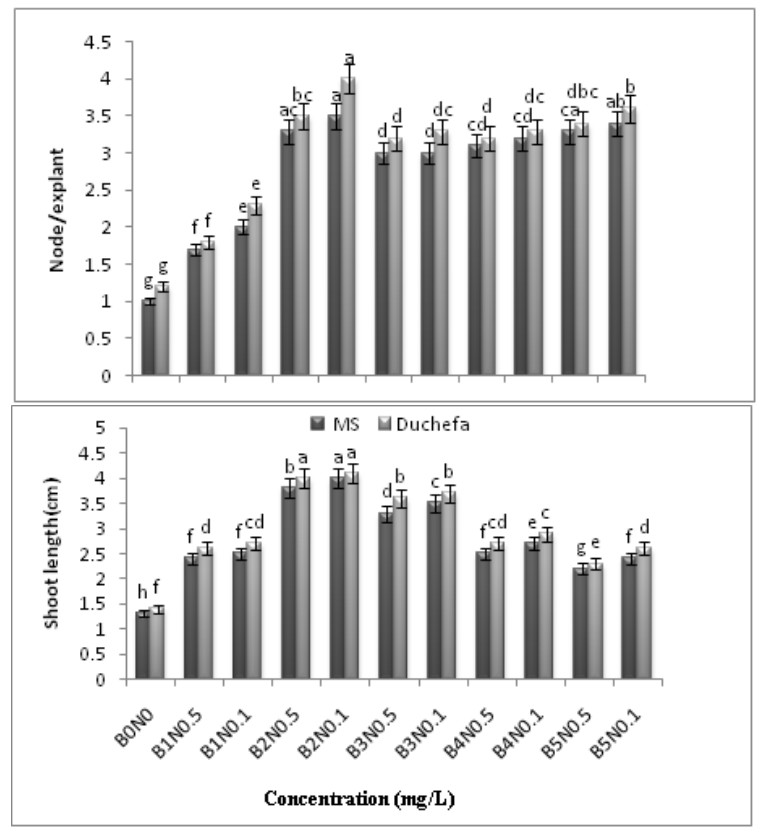
Figure 4. Effects of BAP and NAA concentrations in MS and Duchefa semi-solid media on number of node/explant and shoot length in C.asiatica n = 4 (BAP =